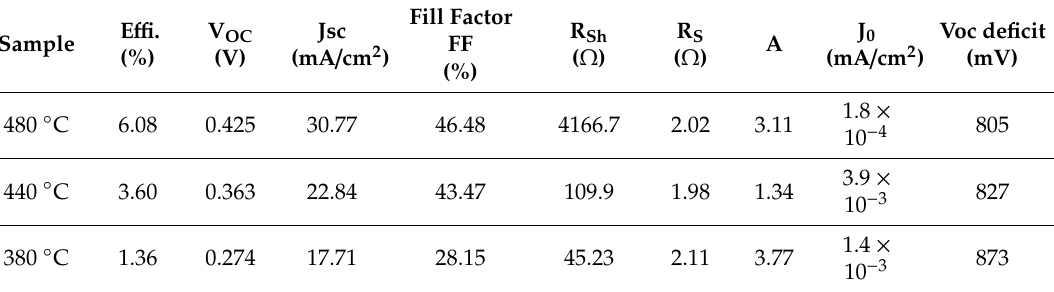
Figure 5. ( a ) Illuminated J-V curves and ( b ) EQE spectra for CZTSe films prepared at various growth temperatures ranging from 380 to 480 °C. Table 1. Summary of photovoltaic parameters of photovoltaic (PV) devices based on the CZTSe films prepared at various growth temperatures. The Voc deficit of Eg –Voc was calculated with an estimated bandgap (E g ) from the EQE spectra fitting, as seen in Figure S1. The estimated bandgap (E g )